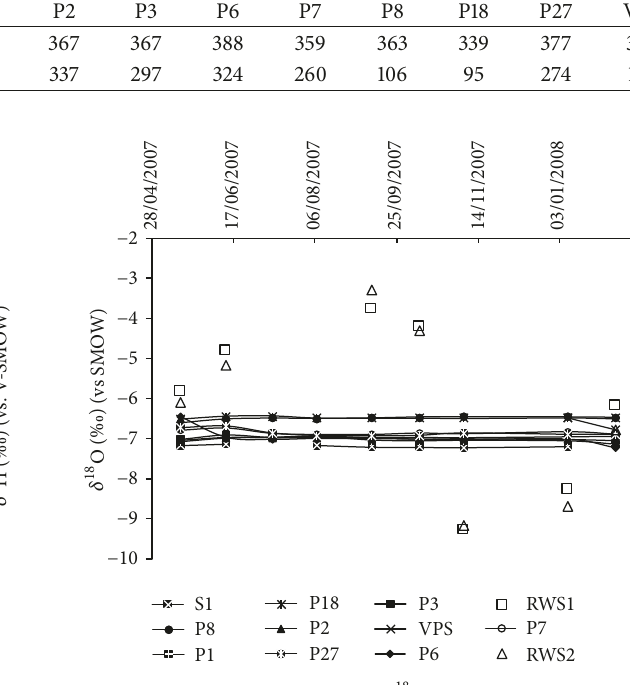
Figure 6: Temporal variation of 𝛿 18 O in groundwater samples, compared with the monthly mean 𝛿 18 O in rainwater